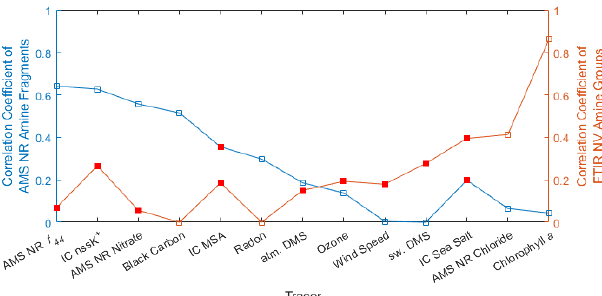
Figure 8. Plot of average Pearson correlation coefficients ( R ) of AMS NR amine fragments (blue) and FTIR NV amine groups in particles with diameters < 1µm (orange) with selected tracers for both marine and continental air masses. Negative correlations were averaged as zero, and only statistically significant ( p < 0 . 05) corre- lations were included, except for markers shown as solid red (which were not significant). No statistically significant correlations were available for AMS NR amine fragments with IC MSA or sea salt nor for FTIR NV amine groups with all tracers with the exception of black carbon, radon, AMS NR chloride, and chl a .